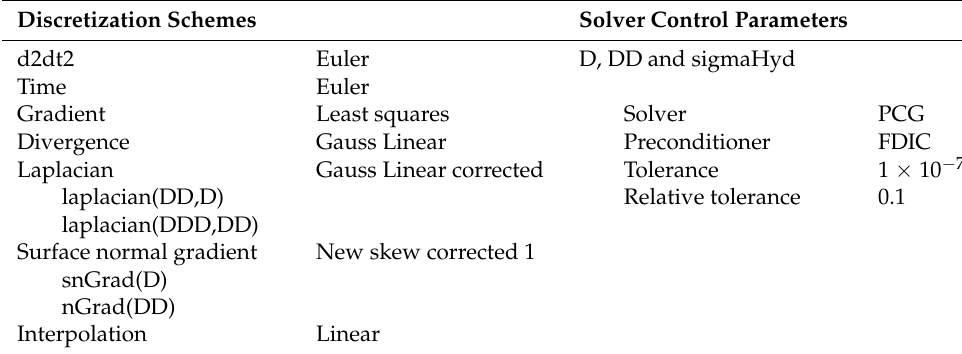
Figure 3. Compression test setup for the safety footwear toe cap-experimental configuration ( left ), computational model with the indication of the boundary patches ( right ). Table 4. Discretization schemes and solver control